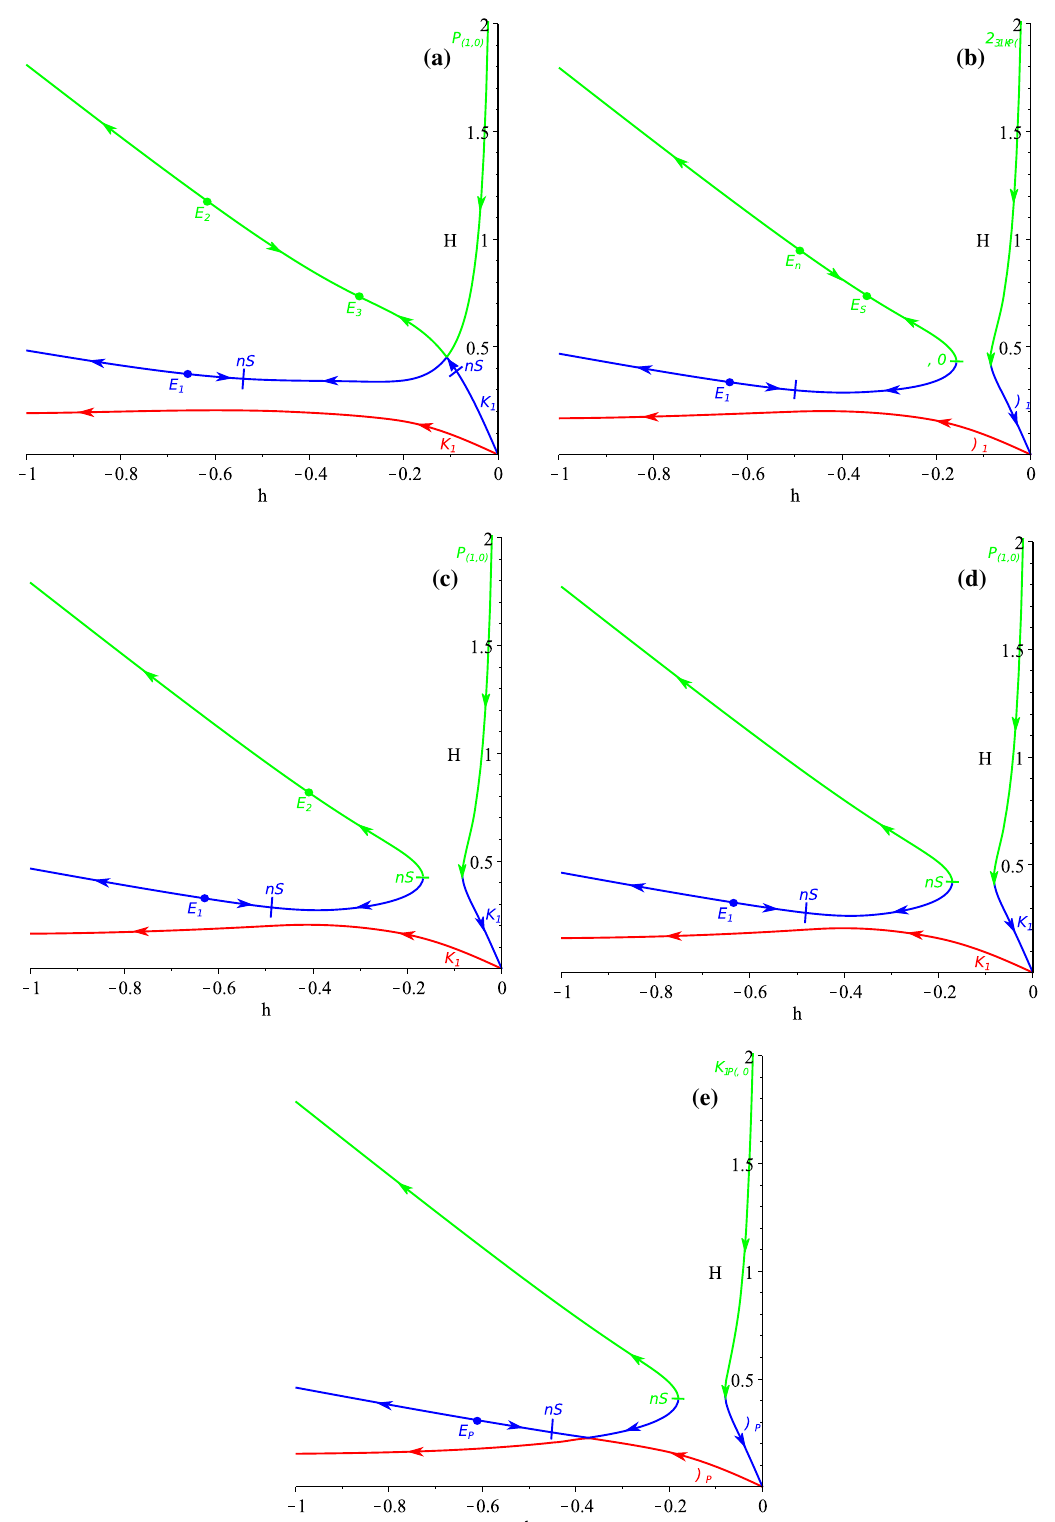
Fig. 4 The fine structure of the solutions in the α > 0, β > 0 D = 6 vacuum case: μ = μ 2 on a , μ 4 > μ > μ 2 on b , μ = μ 4 on c , μ 3 > μ > μ 4 on d and μ = μ 3 on e . Different colors correspond to different branches: H 1 is red, H 2 is blue and H 3 is green, in accordance with Fig. 3 (see the text for more